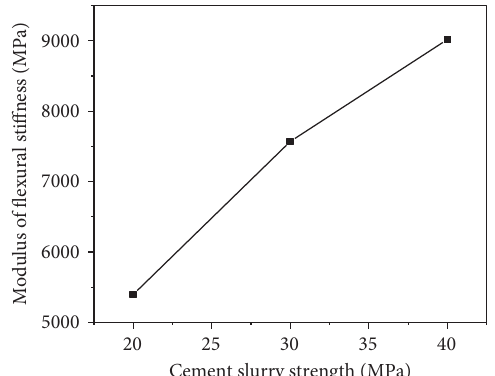
Figure 19: Variation curve of modulus of fexural stifness with the cement slurry strength at − 15 ° C.